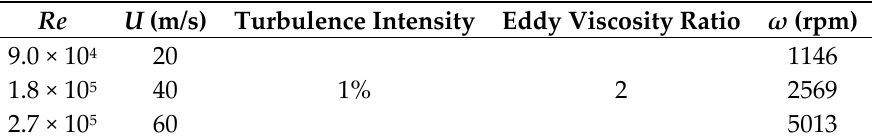
Table 1. Boundary